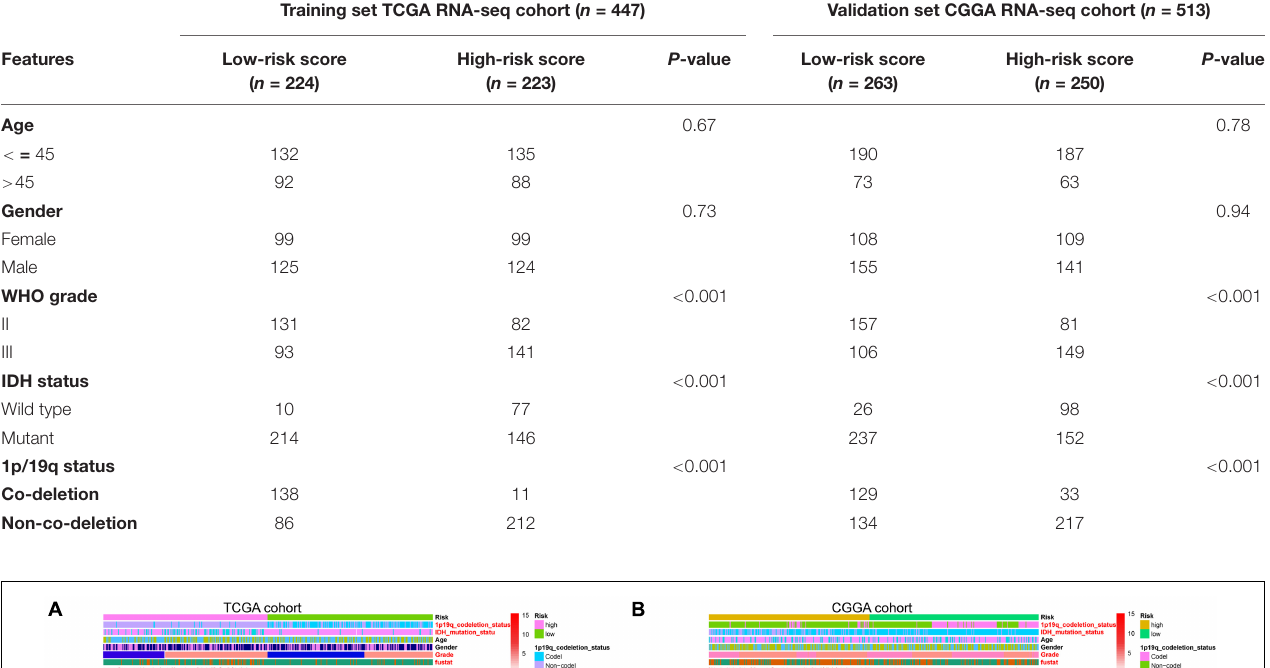
TABLE 1 | Correlation between 14-GSRS genes risk scores and clinicopathological factors of glioma patients in the two cohorts.